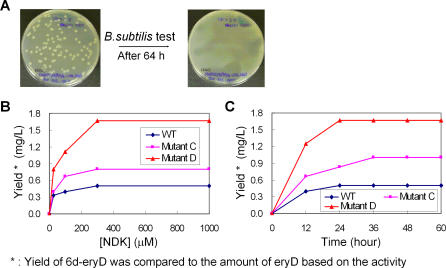
Screening of BAP1/pBP130/pBP175/pHL80*/pHL74 for Mutants (e.g., Mutant C, Mutant D) Capable of Improved Precursor-Directed Biosynthesis(A) Single-colony screening assay of BAP1/pBP130/pBP175/pHL80*/pHL74 with 0.5 mg/ml propionate and 100 μM synthetic diketide substrate (NDK).(B) Kinetics of Mutant C, Mutant D, and wild-type. BAP1/pBP130/pBP175/pHL80*/pHL74 in shake-flask experiments with fixed growth time (48 h), and with different [NDK].(C) Kinetics of Mutant C, Mutant D, and wild-type. BAP1/pBP130/pBP175/pHL80*/pHL74 in shake-flask experiments with fixed [NDK] (300 μM), and at different timepoints.(In shake-flask experiments, the cultures were induced by adding 0.1 mM IPTG at 30 °C with 2.5 g/l propionate and NDK.)